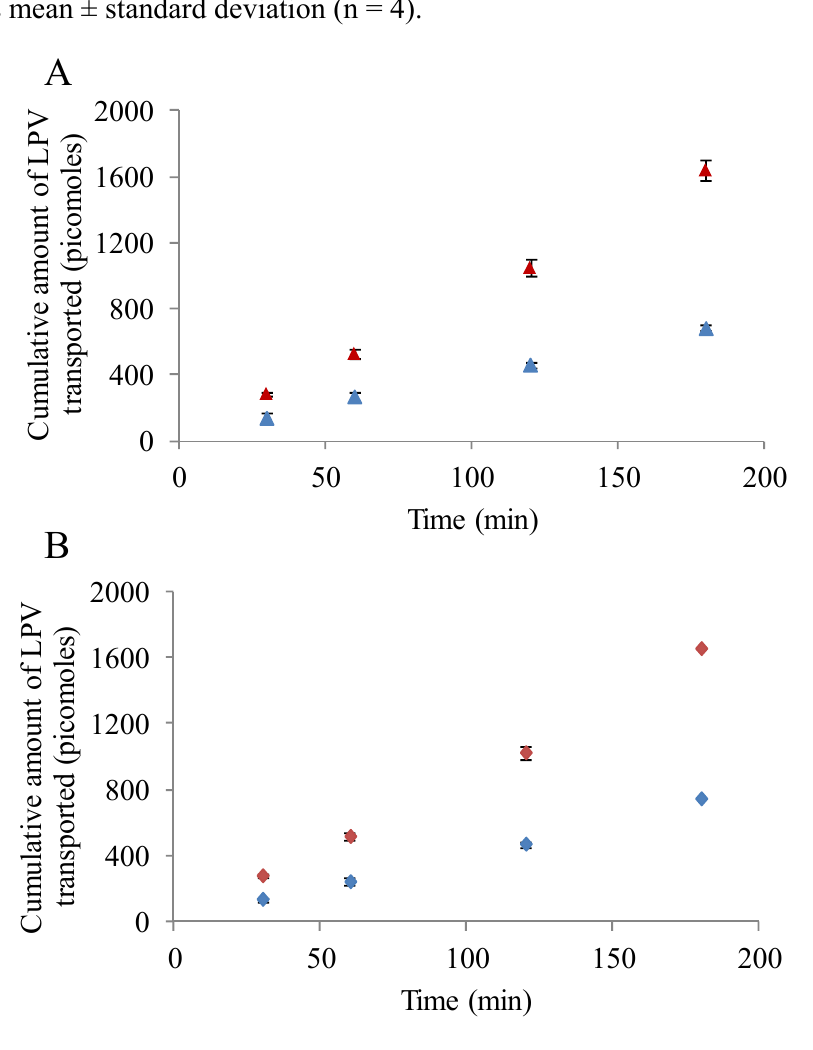
Figure 5. ( A ) Transepithelial bidirectional transport of LPV (25 µM) across MDCK-MDR1 cells in DPBS (pH 7.4) at 37 °C for 180 min. ( Blue ▲ ) represent apical to basolateral transport (A–B) and ( Red ▲ ) represents basolateral to apical transport (B-A). ( B ) Transepithelial bidirectional transport of LPV (25 µM) across MDCK-MRP2 cells in DPBS (pH 7.4) at 37 °C for 180 min. ( Blue ♦ ) represent apical to basolateral transport (A–B) and ( Red ♦ ) represents basolateral to apical transport (B-A). Each data point is expressed as mean ± standard deviation (n =